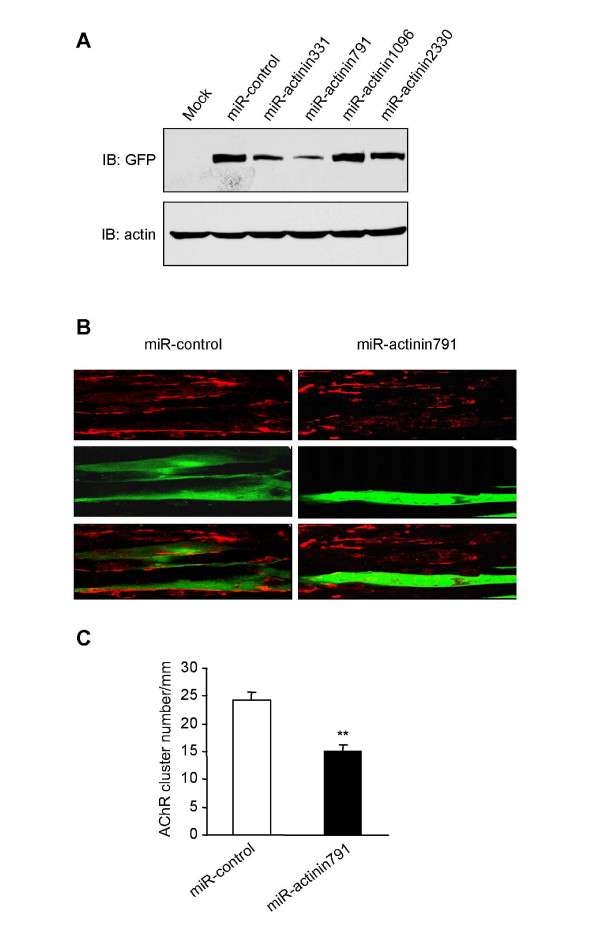
Repression of α-actinin expression impaired agrin-induced AChR clustering. (A) HEK293 cells were transfected with GFP-α-actinin along with indicated miR-RNAi constructs of α-actinin. Thirty-six hours after transfection, cell were lyzed and resulting lysates were immunoblotted with antibodies against GFP. miR-actinin791 showed the strongest inhibition of α-actinin expression. (B) Young C2C12 myotubes were transfected with the control vector or miR-RNA. After 24 hrs the myotubes were treated with agrin for 18 hr. AChR clusters were examined in myotubes expressing GFP that was encoded by the miR-RNAi parental vector. Agrin-induced AChR clusters were reduced in myotubes expressing miR-actinin791, but not miR-control encoding a scrambled sequence. Bar, 20 μm. (C) Quantitative analysis of data in (B). Data were presented as mean ± SEM, n = 20 each group; **, P < 0.01.